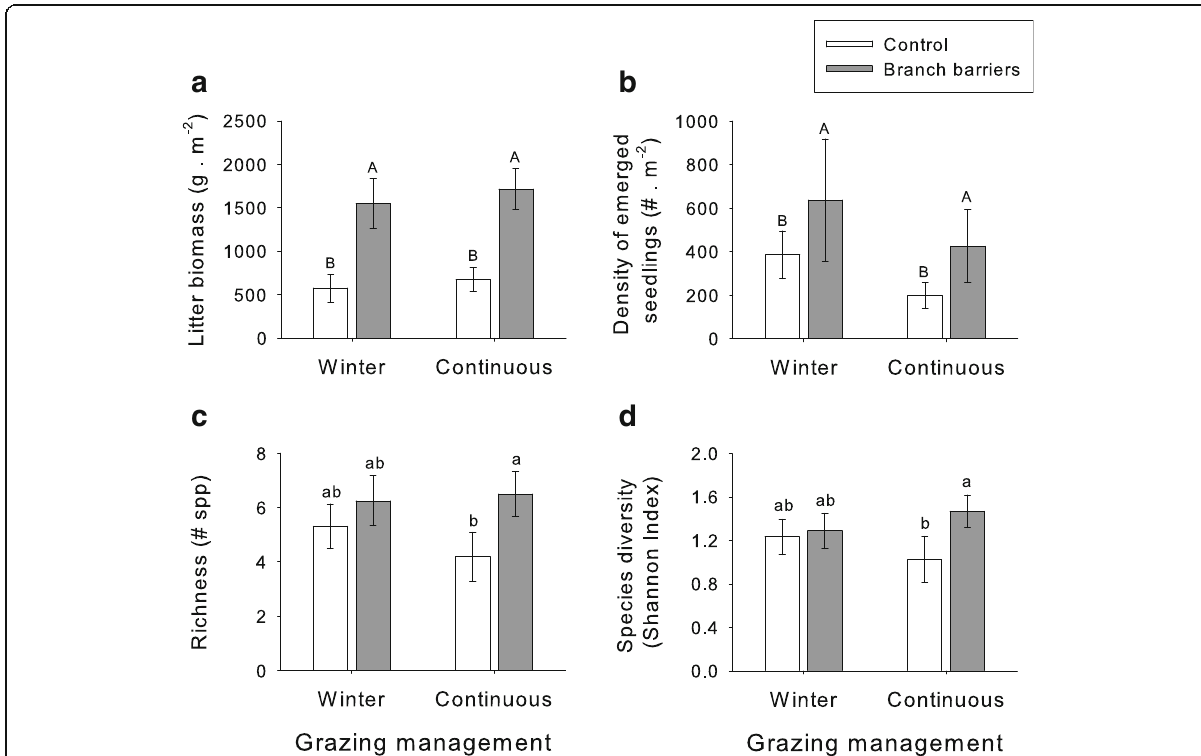
Fig. 3 Mean (± standard deviation, SE) of litter biomass ( a ), density ( b ), richness ( c ), and diversity ( d ) of seedlings emerged from soil seedbank in water run-off paths with and without branch barriers under different grazing managements: winter (a 1-ha temporary enclosure in which grazing was excluded until winter season, when it was grazed with a stocking rate adjusted to annual forage availability), and continuous (a 1-ha paddock that remained open to grazing throughout the year with a stocking rate of 0.16 AU ha − 1 ). Different lowercase letter showed significant differences for grazing management × branch barriers interaction ( ɒ = 0.05). Different uppercase letters indicated significant differences between levels of one factor ( ɒ =